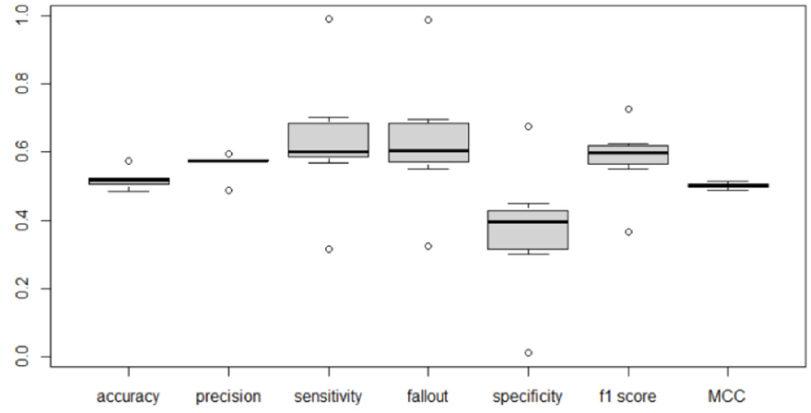
Figure 16. Test indicator distribution.